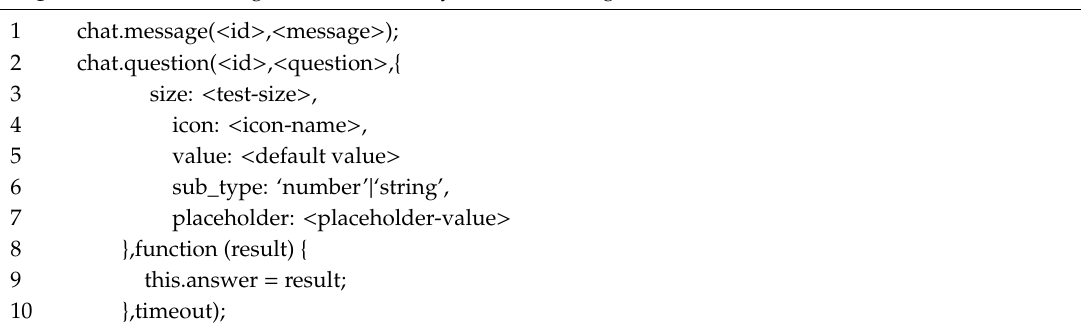
Algorithm 2. Chat dialogue API accessed by the mediator